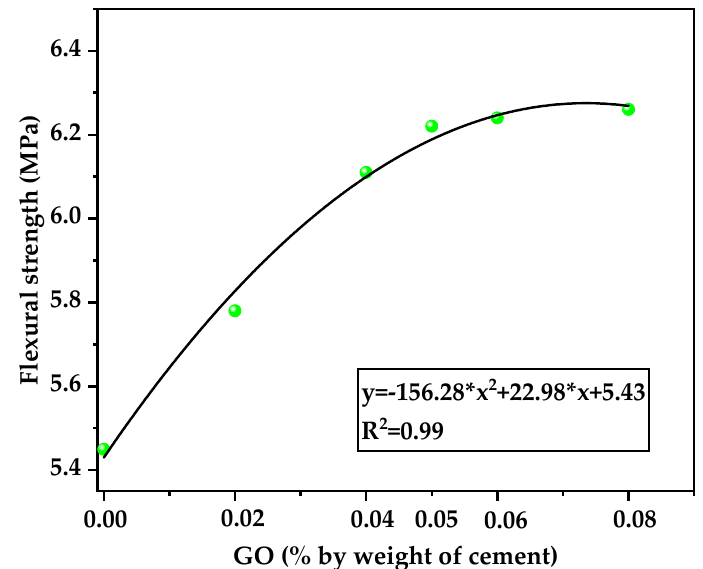
Figure 7. Relationship between GO and the 28-day flexural strength of concrete.